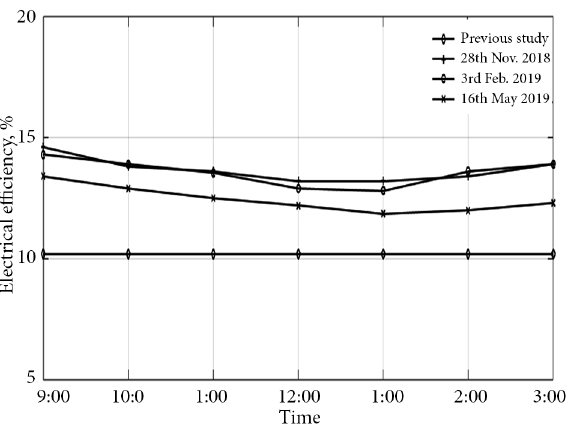
Figure 7. Comparison experimental efficiencies for different three days with previous study